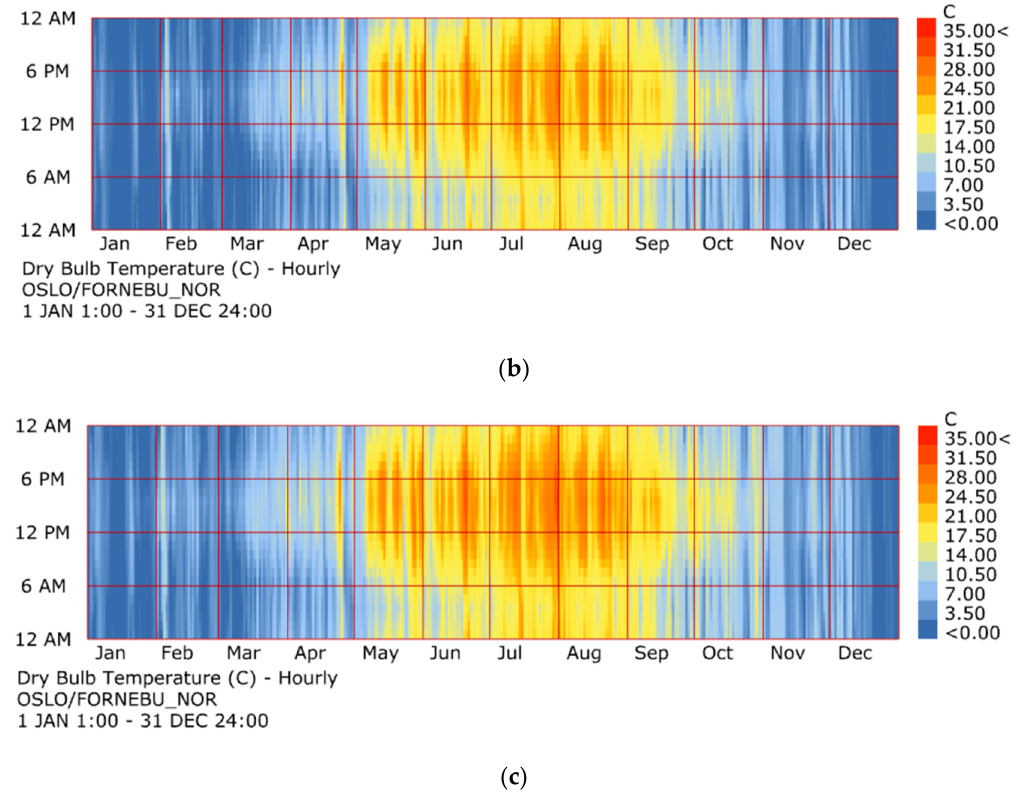
Figure 6. Hourly dry bulb temperature during one year in Oslo, Norway ( a ) present-day weather file, ( b ) 2050 weather file, ( c ) 2080 weather file.